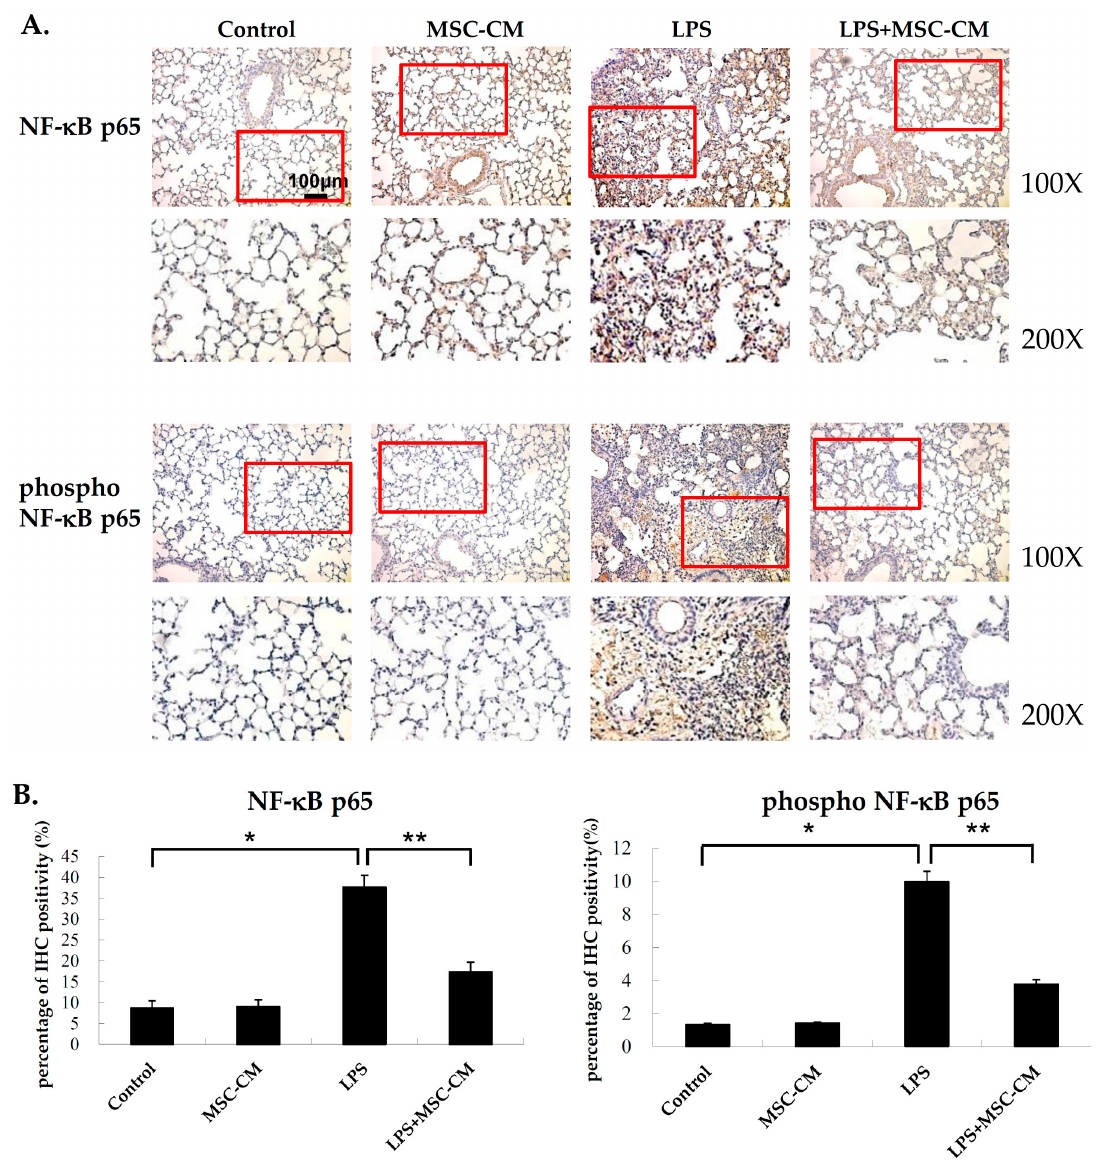
Figure 5. Administration of the MSC-CM reduced the expression levels of total and phosphorylated NF-kB p65 in mice with LPS-induced ALI. ( A ) Lung tissues from the mice challenged with LPS (LPS) exhibited more positive staining for total NF-kB p65 than control mice (Control). In contrast, lung tissues from mice that received LPS + MSC-CM exhibited a significant decrease in total NF-kB p65 staining compared to the LPS mice. Staining of phospho-NF-kB p65 was enhanced in lung tissues from the LPS mice compared with control mice, and staining was significantly reduced in lung tissues from the mice that received LPS + MSC-CM compared to the LPS mice. ( B ) The quantification of IHC staining showed the similar results. Magnification = 100 × and 200 × (red box). Scale bar = 100 µ m. For both sets of staining, quantitation of staining intensity is presented as the mean ± SD in bar graphs. * p < 0.05, compared to the controls; ** p < 0.05, compared to the LPS group; n = 6 per